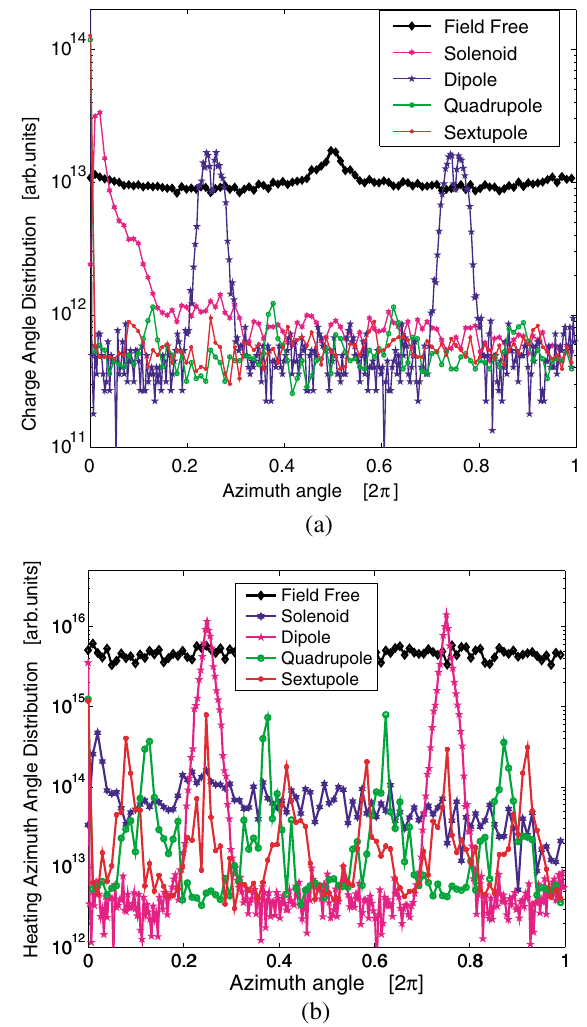
FIG. 17. (Color) Charge and heat-load azimuth angle distribu- tions of photoelectrons lost to the chamber wall in differ- ent magnetic fields. (a) Charge distribution; (b) heat-load